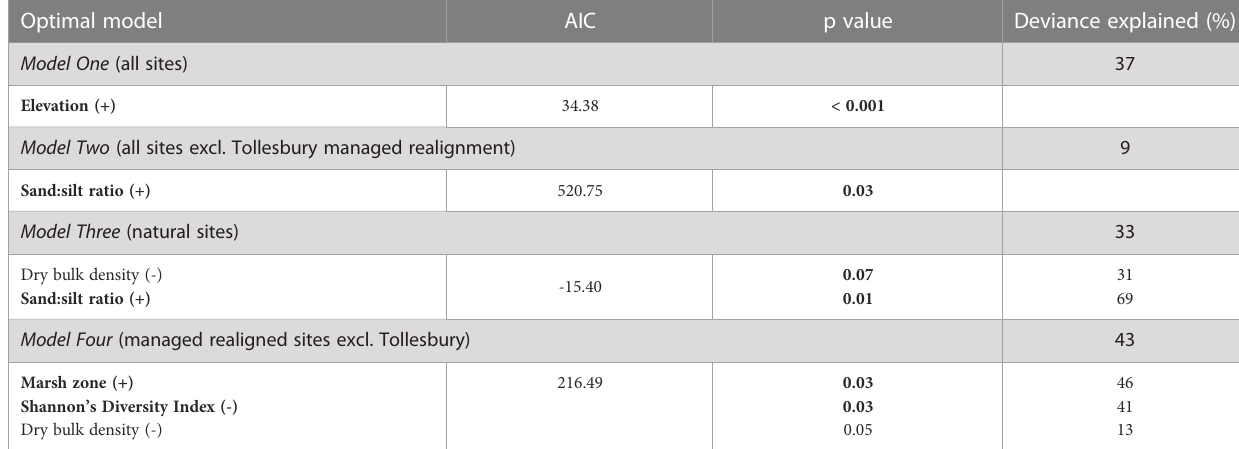
TABLE 4 Multivariate general and generalized linear models of carbon stock vs environmental predictor variables. Optimal